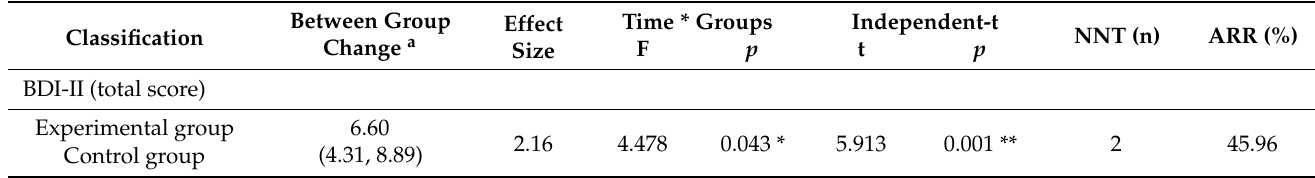
Table 10. Changes in depression between intervention on two intervention